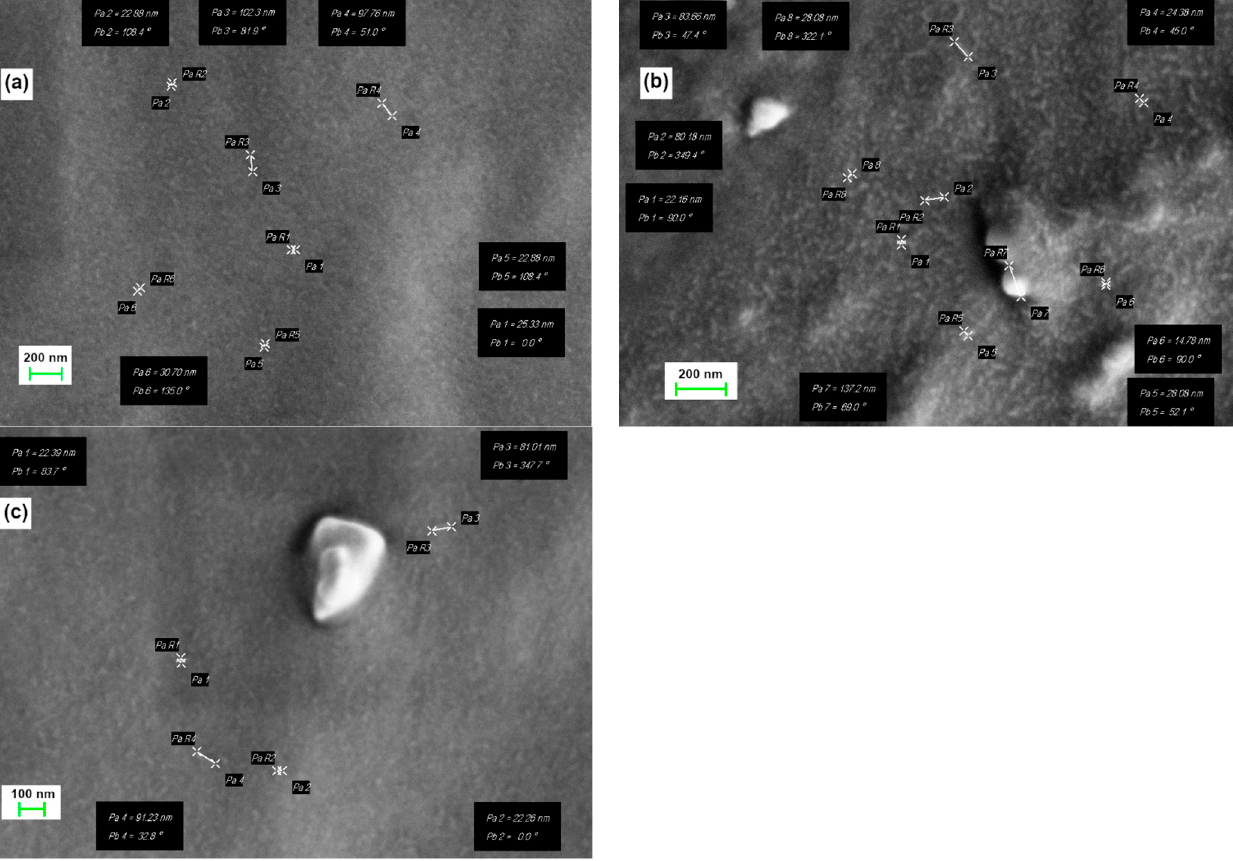
Figure 1. SEM images of films BCP I casted from butyl acetate ( a ) and from toluene ( b ), and BSP II casted from ethyl acetate ( c ).